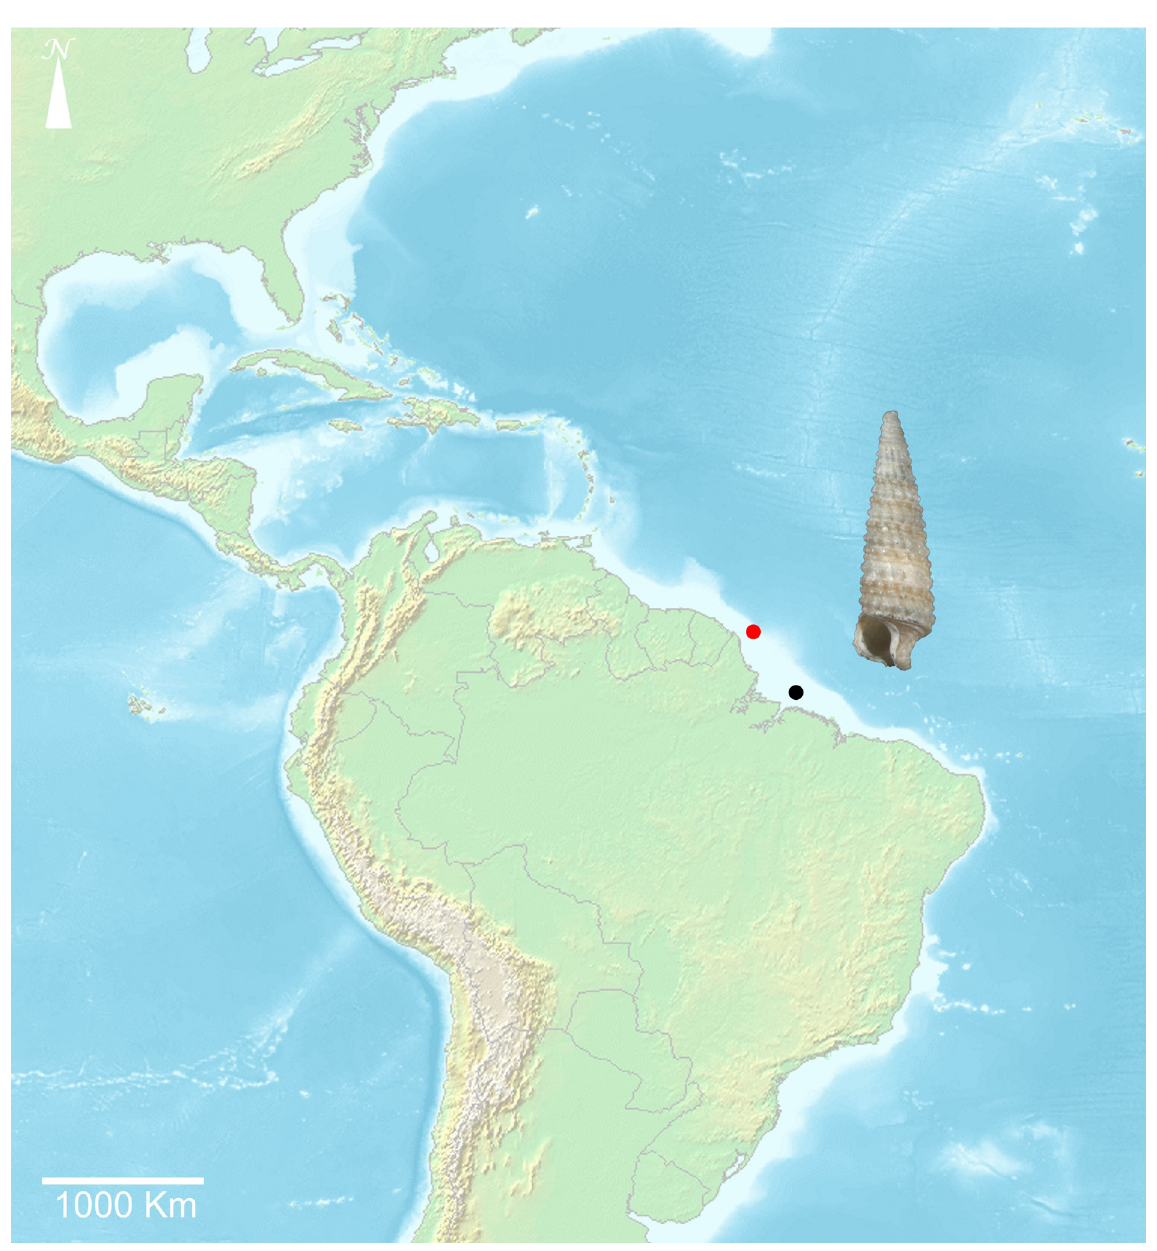
Fig. 43. Distribution map of “ Inella ” vanilla Fernandes & Pimenta, 2019; red circle = type